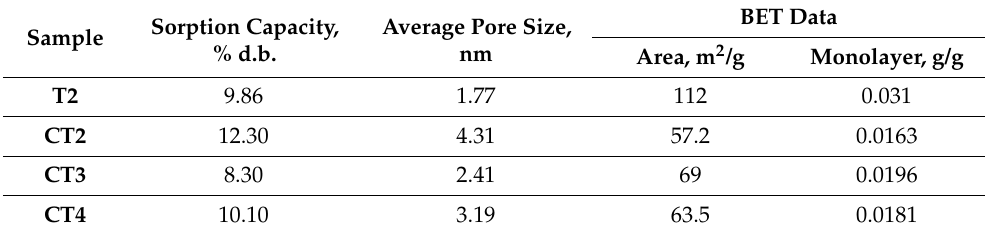
Figure 3. Adsorption (S) and desorption (D) isotherms for pure TiO 2 and Cu-doped TiO 2 composites. Table 2. Dynamic water sorption vapor data for the tested materials.